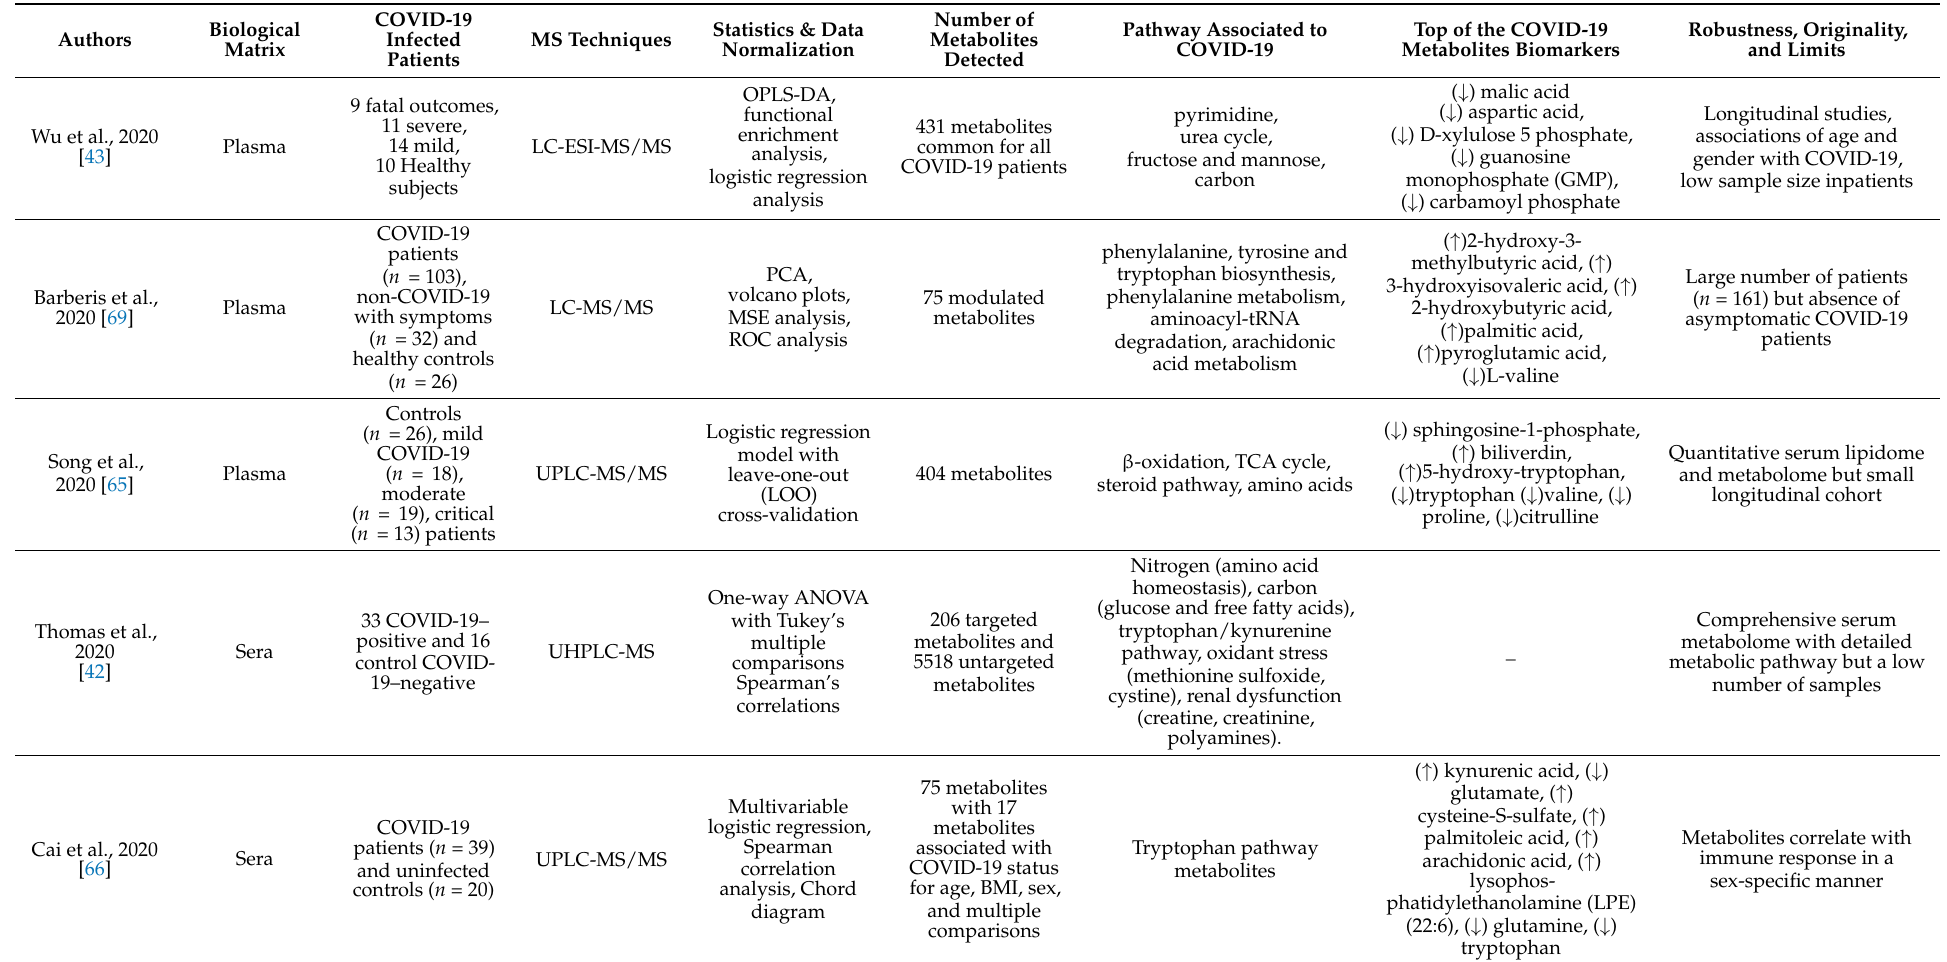
Table 1. Metabolite prognostic and diagnosis associated with COVID-19 disease using metabolomic